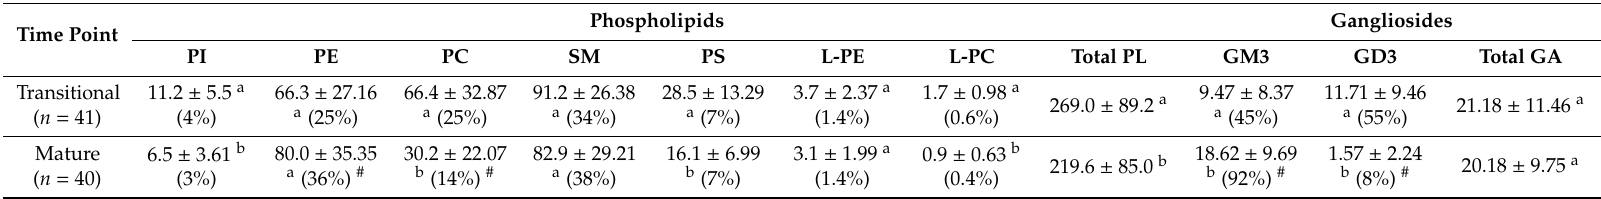
Table 2. Phospholipid (PL) and ganglioside (GA) concentrations in transitional and mature breast milk. SM, sphingomyelins; PC, phosphatidyl choline (PC); L-PC, PC lyso species; PE, phosphatidyl ethanolamine; L-PE, PE lyso species; PI, phosphatidyl inositol; PS, phosphatidyl serine; GD3, disialoganglioisde 3; GM3, monosialoganglioside